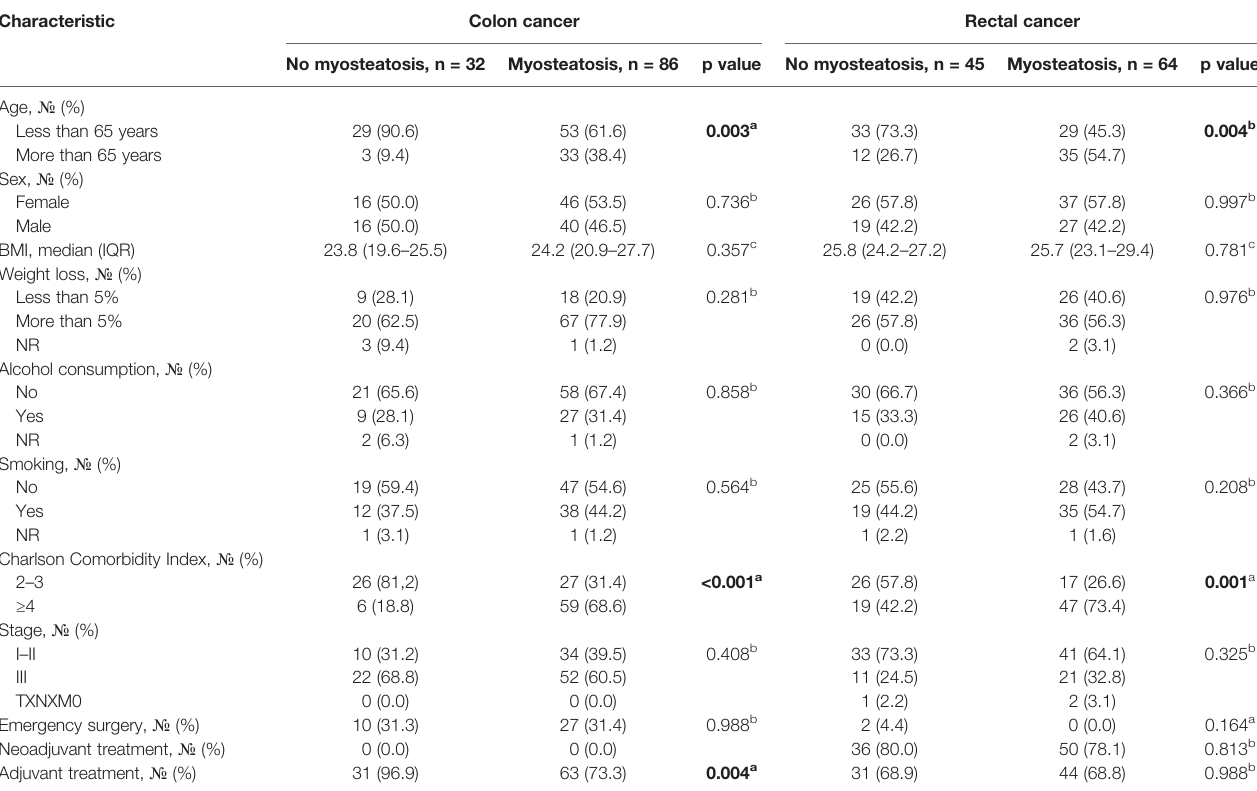
TABLE 1 | Selected demographic and disease characteristics according to myosteatosis of stage I – III colon and rectal cancer patients.